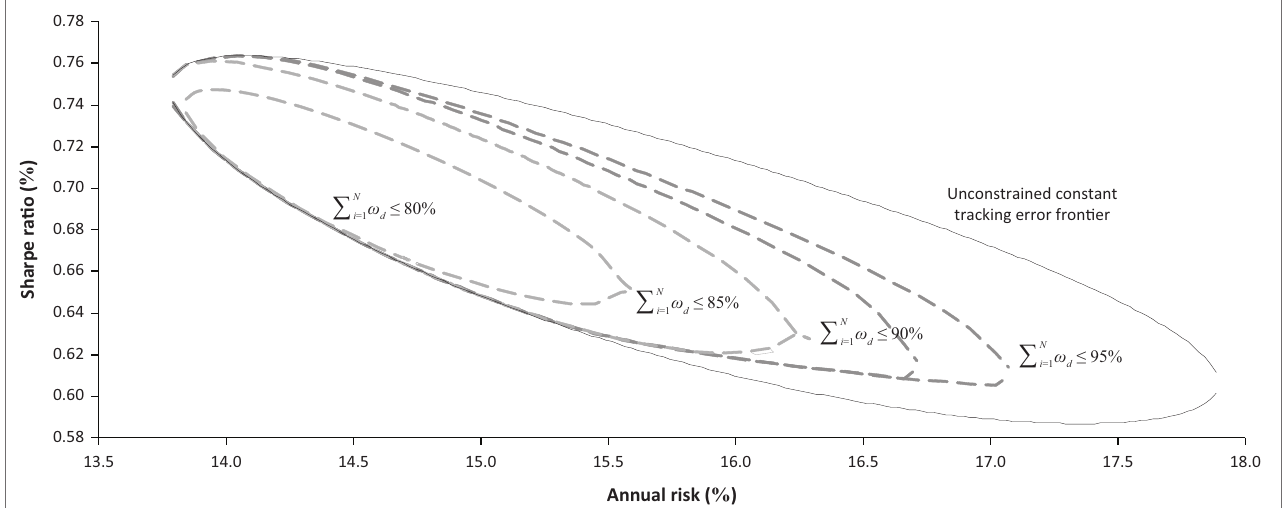
FIGURE 7: Sharpe ratios versus annual portfolio risk for TE = 5 % and ∑